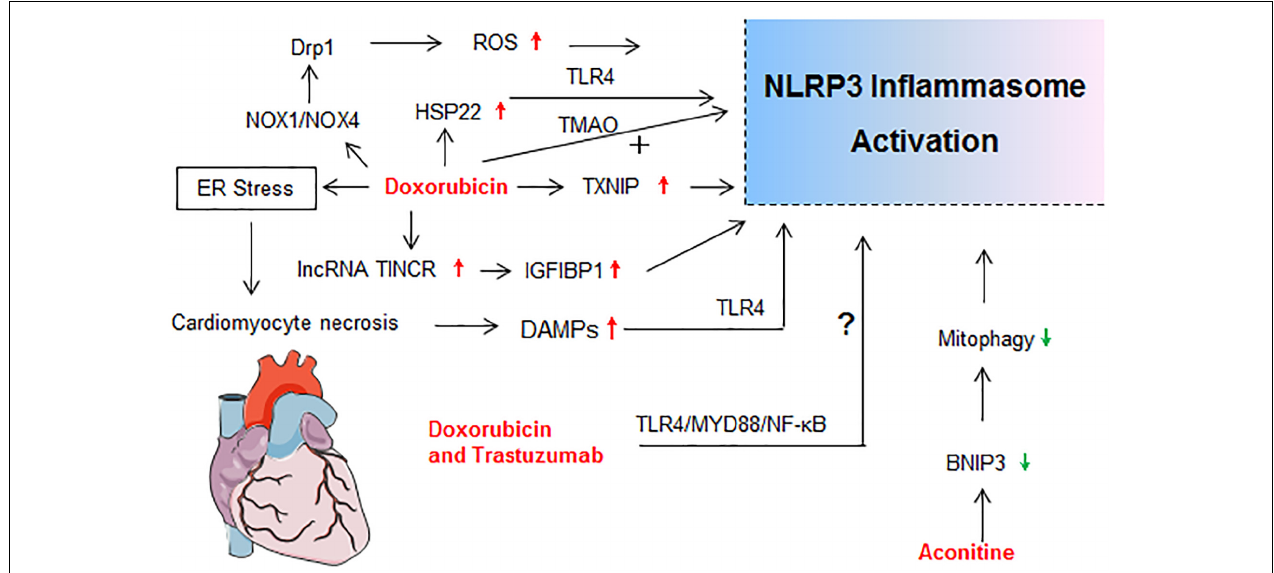
FIGURE 4 | Molecular mechanisms of NLRP3 activation in drug-induced cardiotoxicity. drp1, dynamin-related protein 1; ER stress, endoplasmic reticulum stress; HSP22, heat shock protein 22; IGF2BP1, insulin like growth factor 2 mRNA binding protein 1; lncRNA TINCR, terminal differentiation-induced non-coding RNA;